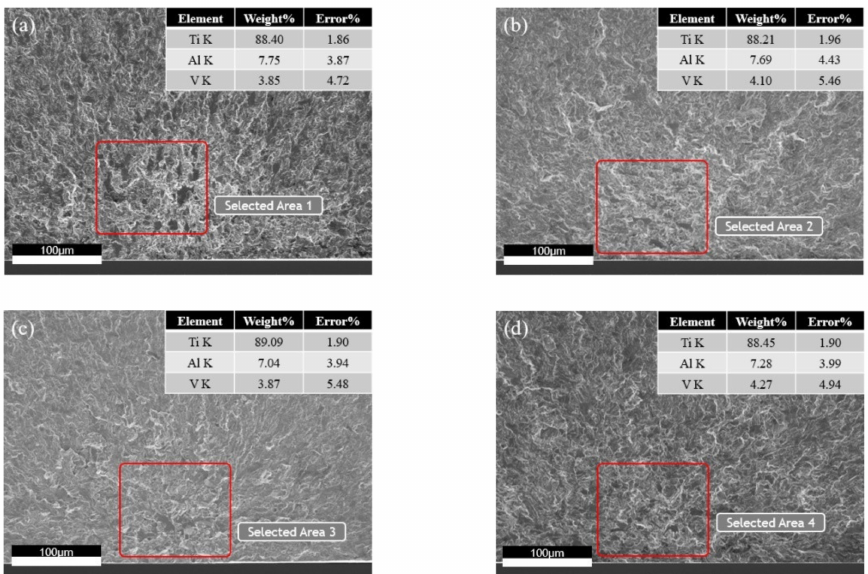
Figure 11. EDS analysis of facet clusters in ultra-high-cycle-fatigue crack origin zone. ( a ) Equiaxed I, σ a = 218 MPa, N f = 6.06 × 10 8 ; ( b ) equiaxed II, σ a = 233 MPa, N f = 3.16 × 10 8 ; ( c ) bimodal I, × 10 8 ; ( d ) bimodal II, σ a = 233 MPa, N × 10 8 σ a = 225 MPa, N f = 4.15 f = 3.25